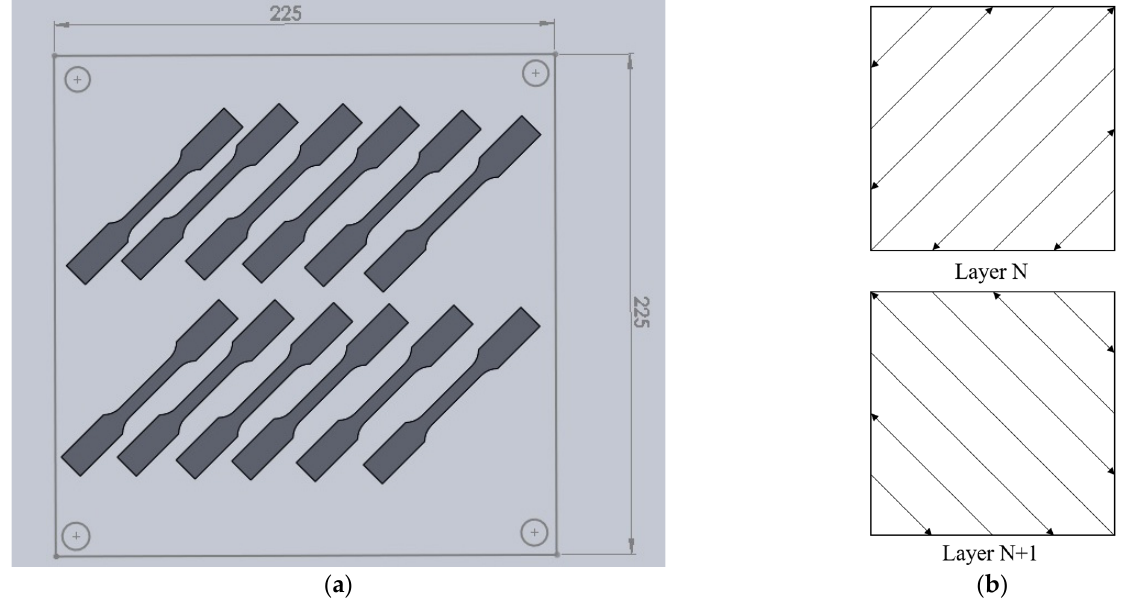
Figure 1. Schematic of ( a ) specimen placement (dimensions in mm) and ( b ) layer-related scanning strategy.